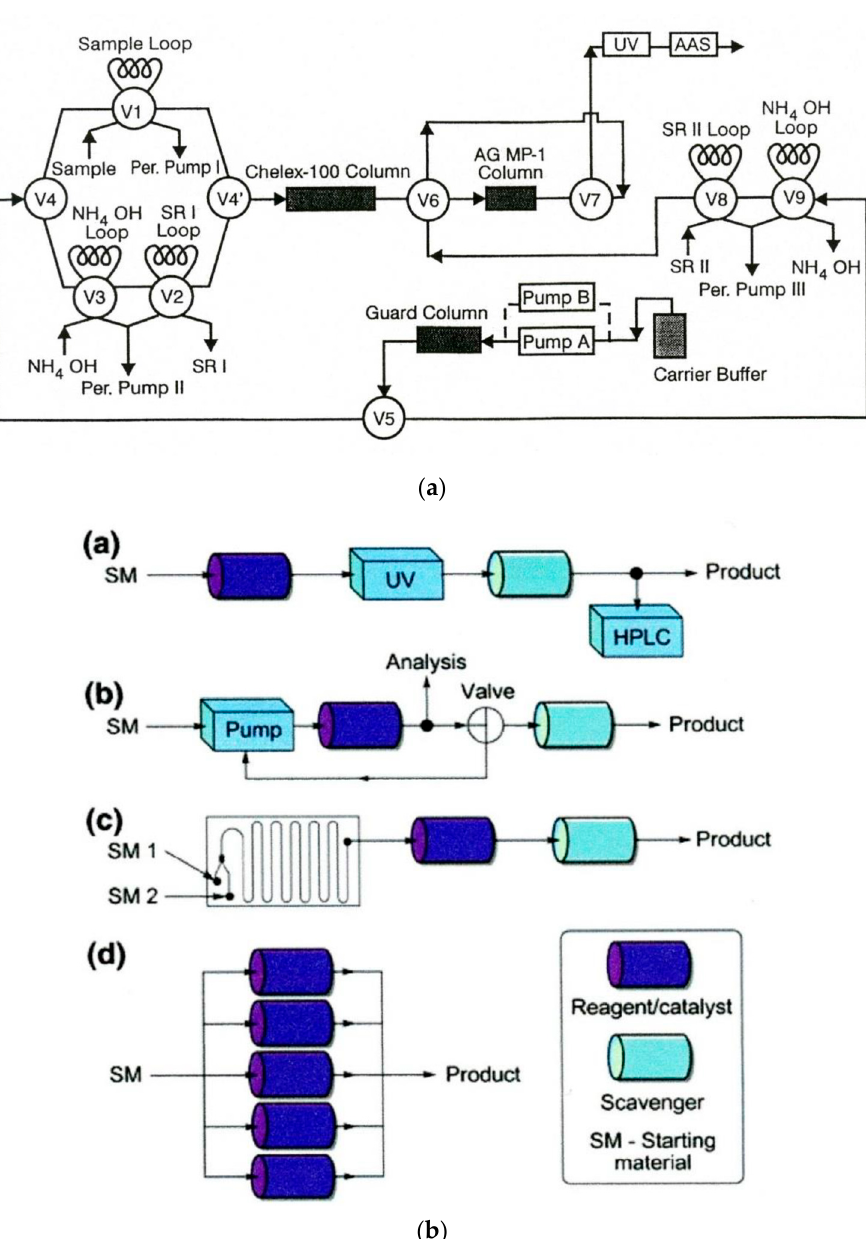
Figure 4. Examples of the application of solid sorbents in flow analysis ( a ) and flow synthesis ( b ) systems: ( a ) schematic diagram of flow-injection system with flame atomic absorption spectrometry detection for speciation of Cd, Cu, and Zn with the use of Chelex-100 chelating resin and anion-exchange AG MP-1 resin [184]; ( b ) schematic presentation of the main concepts of the arrangement of solid-supported reagents for continuous-flow synthesis [185]. a—linear configuration of series of flow-through column reactors with in-line and on-line analytical monitoring; b—recirculating set-up for processes requiring a longer reaction time; c—set-up combining streams and a flow-through reactor; d—parallel set-up of reactors for producing a larger amount of products.